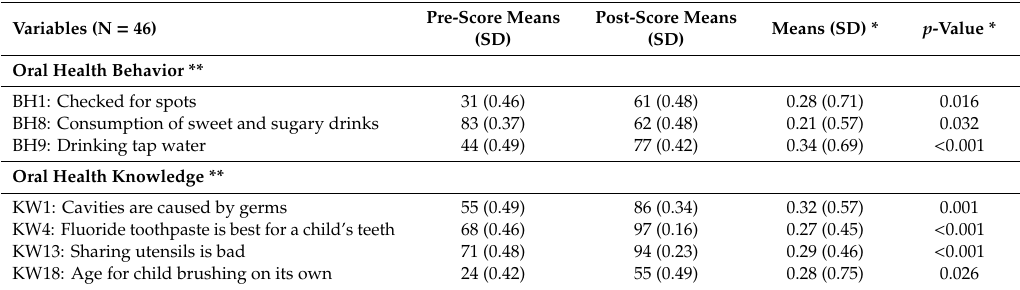
Table 2. Di ff erence in the pre- and post-oral health prevention intervention variable